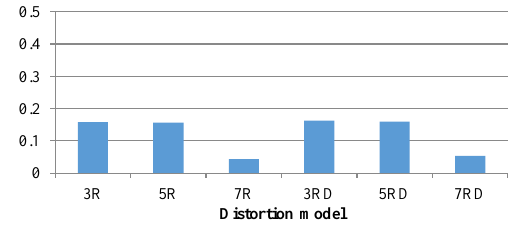
Figure 5. Results of camera calibration